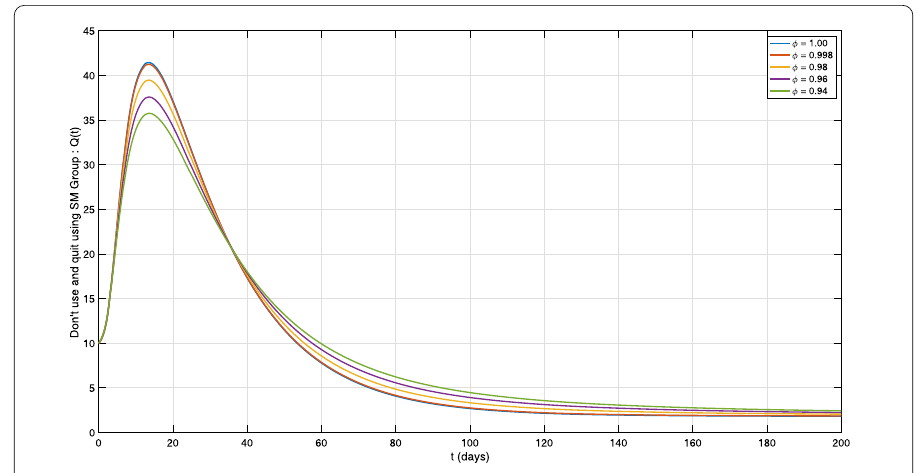
Figure 7 The quantity of Q ( t ) with φ = 0.94,0.96,0.98,0.998,1.00